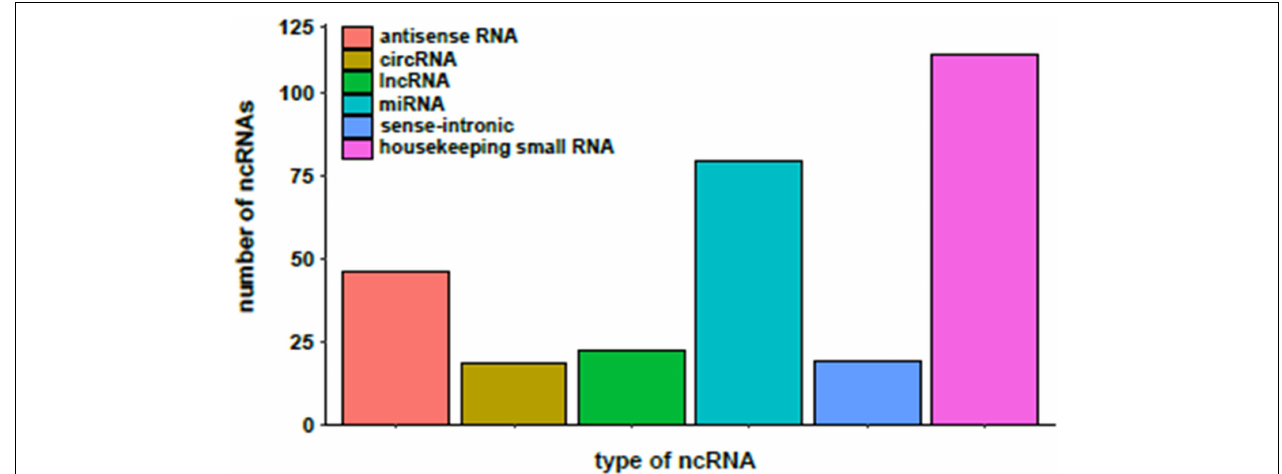
FIGURE 3 | Distribution of the different categories of non-coding RNAs (ncRNAs) differentially expressed in the BeWo-FSK.